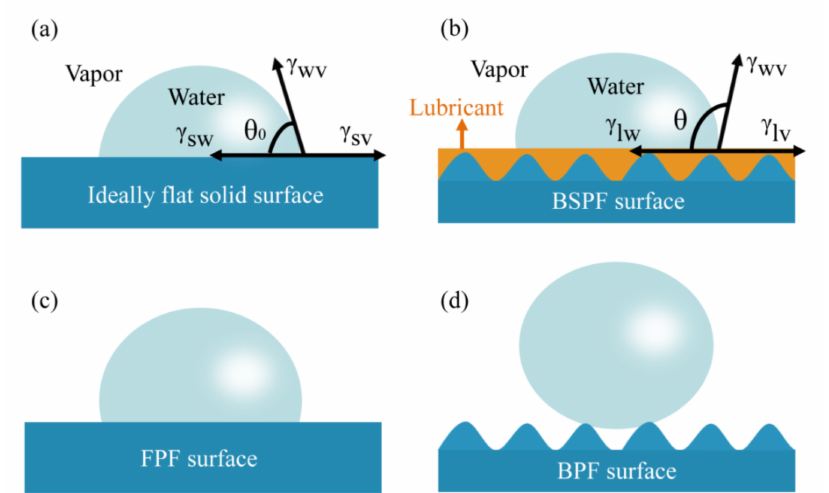
Figure 4. Schematic showing a liquid droplet sitting on an ideally flat solid surface ( a ), a BSPF surface ( b ), FPF surface ( c ) and BPF surface ( d